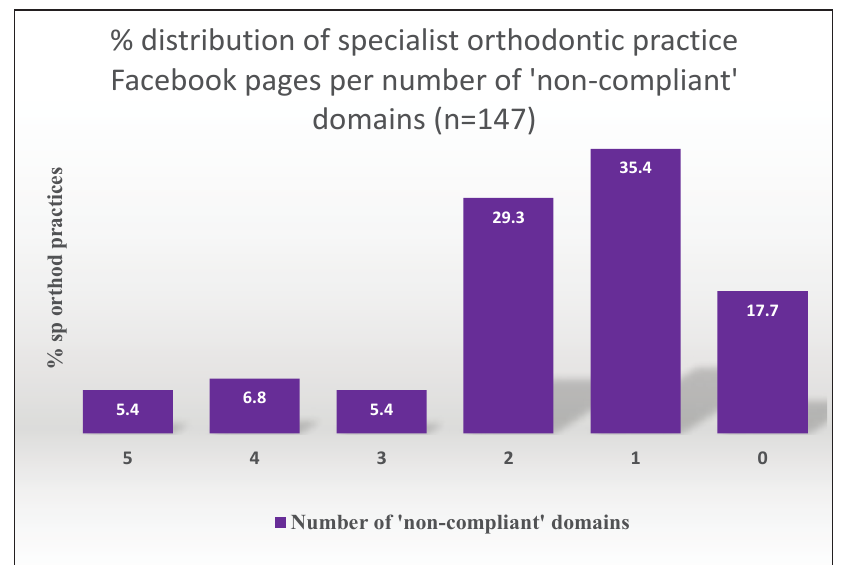
Figure 3. % distribution of specialist orthodontic practice Facebook pages per number of ‘non-compliant’ domains